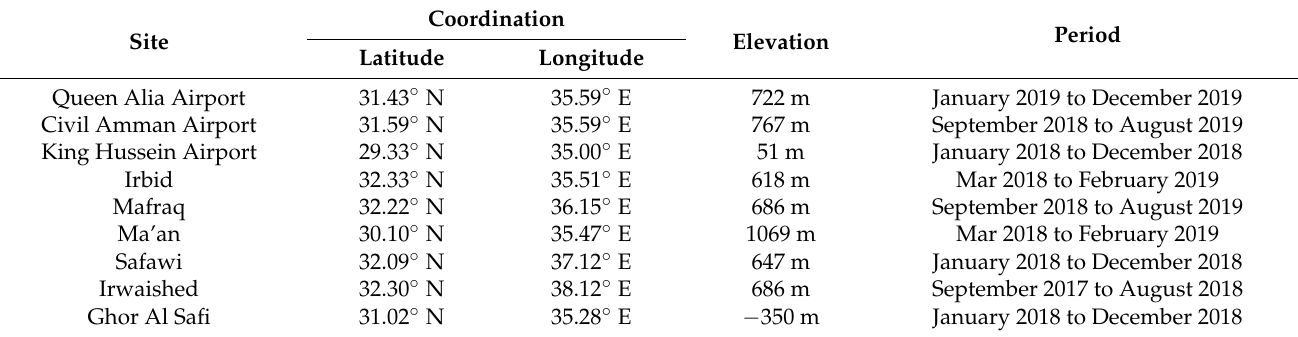
Table 1. Distribution of wind sites in Jordan.